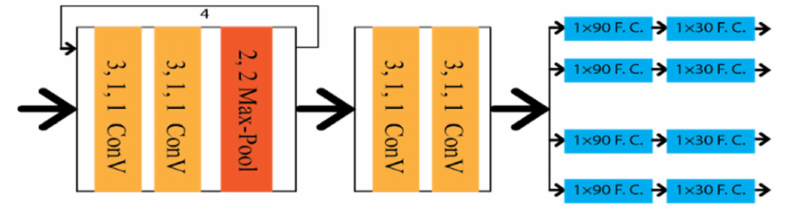
Figure 11. Schematic diagram of CooNet.